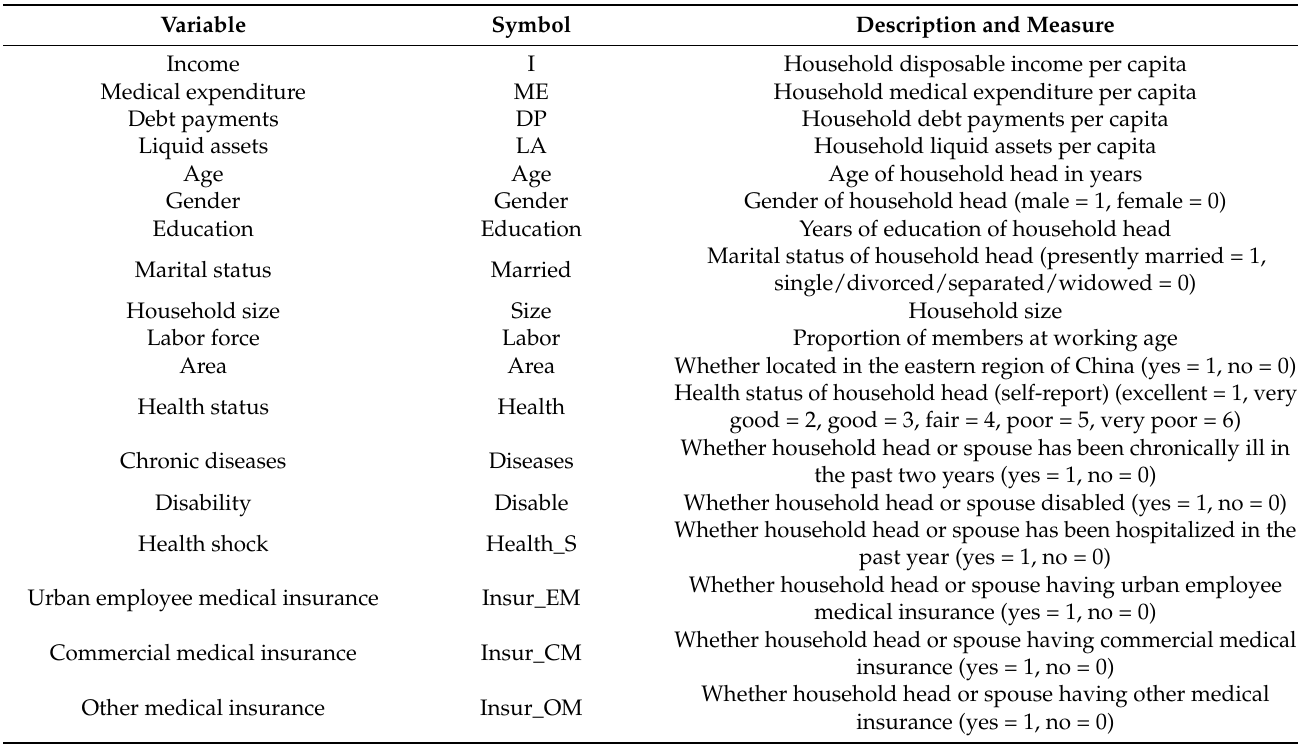
Table 1. Variables and their